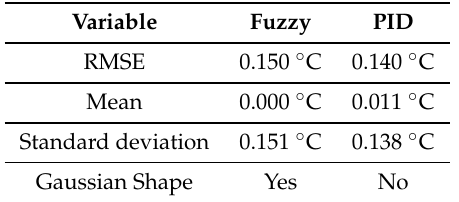
Table 6. Results for the external temperature